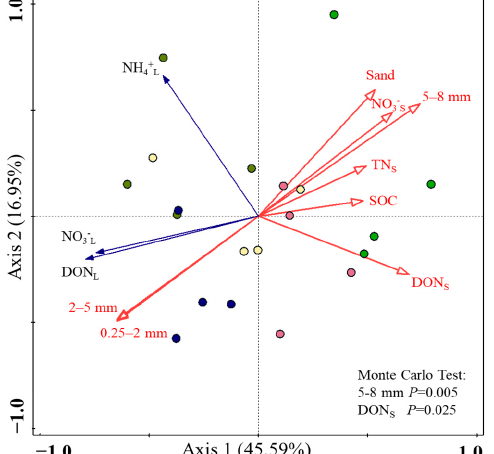
Figure 5. Effect of soil properties on nitrogen in leachate (including NO 3 ¯, DON, and NH 4+ ) accord- ing to RDA analysis. TN S , NO 3 ¯ S , and DON S represent total nitrogen, nitrate, and dissolved organic nitrogen in soil under tillage disturbance after one year. NO 3 ¯ L , DON L , and NH 4+L represent the cu- mulative amounts of nitrate, dissolved organic nitrogen, and ammonium in leaching water during